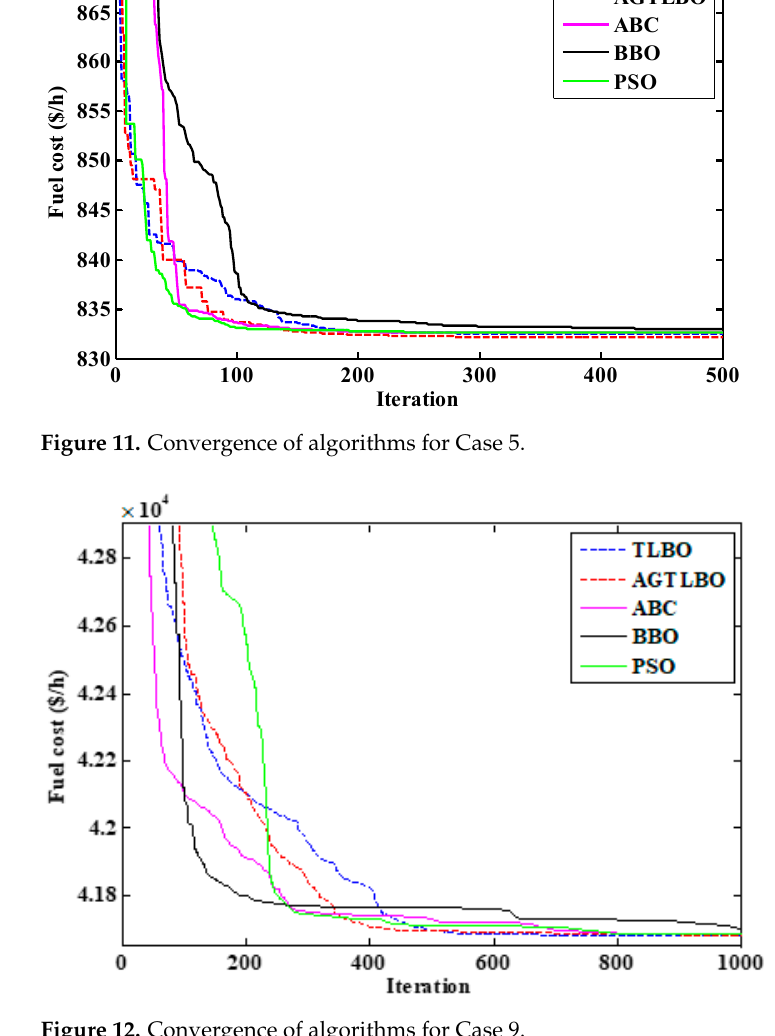
Figure 12. Convergence of algorithms for Case 9.